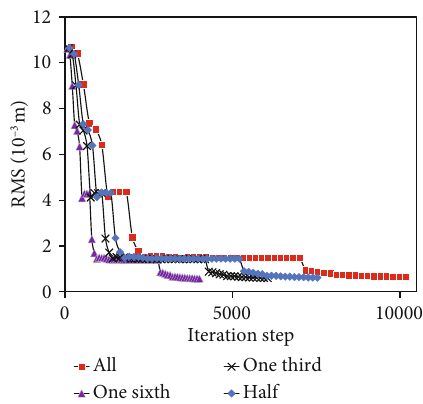
Figure 8: Iteration process of RMS error of the front cable net (interior point algorithm).